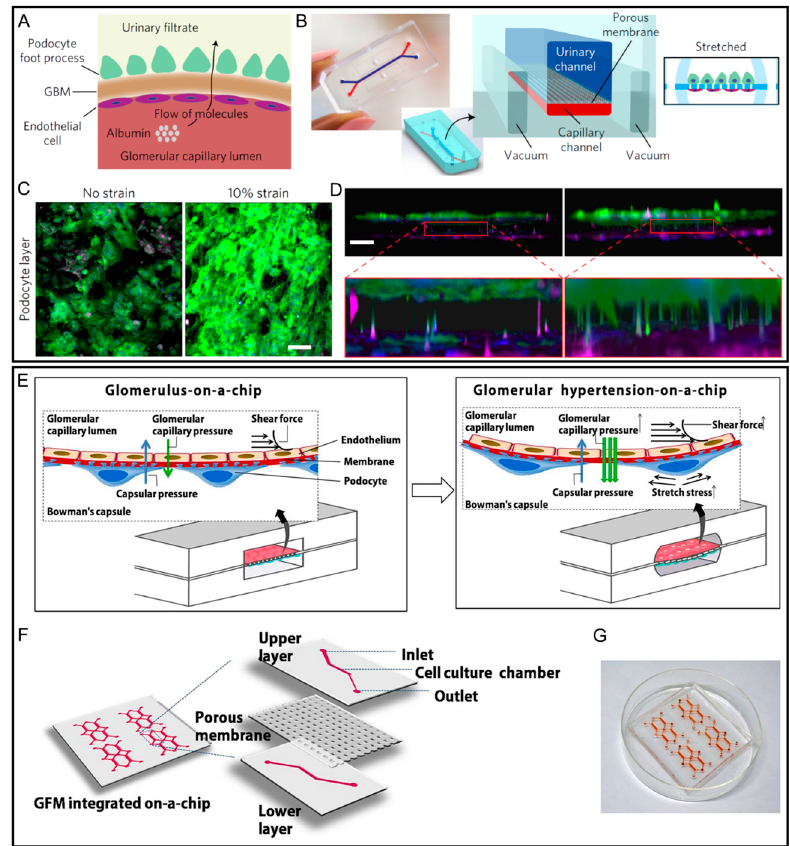
Figure 2. Kidney-on-a-chip platforms with microfluidic actuators. ( A ) Schematic representation of glomerular capillary wall with podocytes and endothelial cells separated by the glomerular basement membrane. An arrow shows directional flow of molecules from the capillary lumen to urinary space. ( B ) Photograph and schematic of the microfluidic organ-on-a-chip device with microchannels replicating the urinary and capillary compartments of the glomerulus. ( C ) Immunofluorescence microscopy images of podocytes differentiated in the device with or without a 10% mechanical strain. ( D ) Reconstructed side view of the tissue–tissue interface formed by hiPS-cell-derived podocytes (top, green) and human glomerular endothelial cells (bottom, magenta) showing that cyclic application of strain enhanced the extension of podocyte cell processes through the pores of the PDMS membrane. Scale bars are 100 µ m. Reproduced with permission from [57]. ( E – G ) Schematics and image of the glomerulus-on-chip device. Mice glomerular endothelial cells (GEnCs) and mice podocytes (MPC-5) are cultured to confluence monolayers on both sides of the PDMS membrane for mimicking the glomerular filtration barrier. Perfused flow within the microchannel can induce shear stress, glomerular capillary pressure, and a stretching stress to reproduce glomerular hemodynamics in vitro. Reproduced with permission from